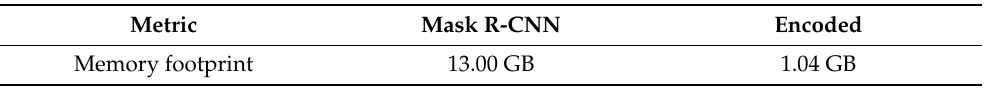
Figure 4. Mask R ‐ CNN output and the encoding process integration; the encoding process will uti ‐ Figure 4. Mask R-CNN output and the encoding process integration; the encoding process will utilize lize the object IDs and combine all masks into a single global mask. the object IDs and combine all masks into a single global mask. Table 1. Comparison between the raw Mask R ‐ CNN physical memory needs and the encoded Mask Table 1. Comparison between the raw Mask R-CNN physical memory needs and the encoded Mask R ‐ CNN physical memory needs for 300 frames. R-CNN physical memory needs for 300